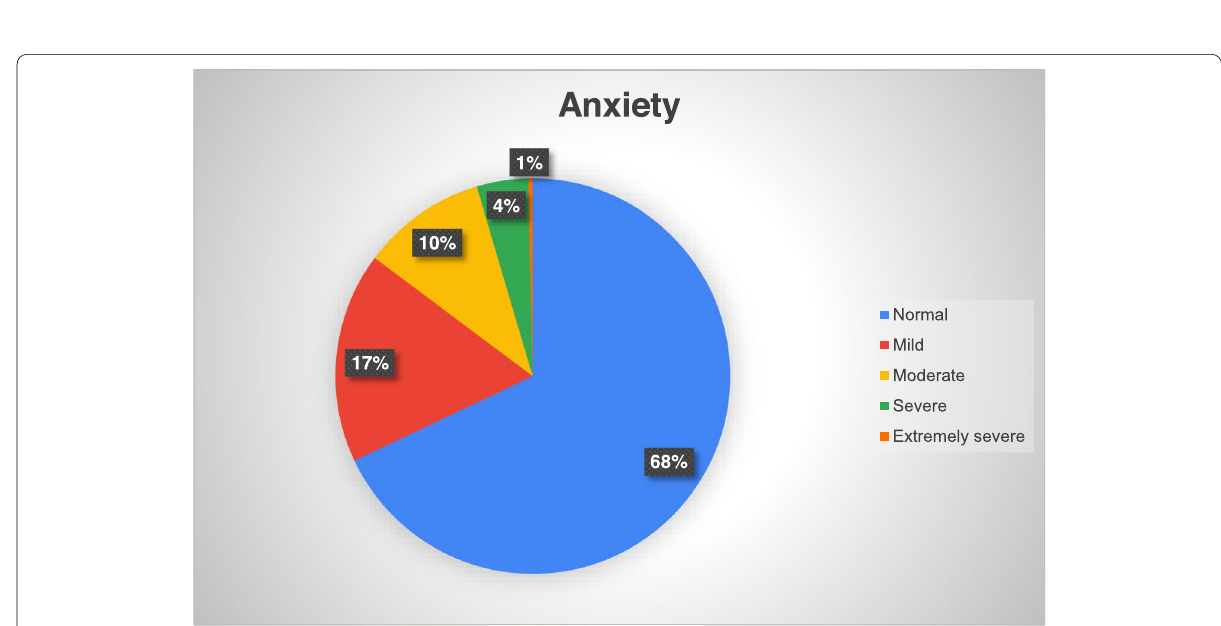
Fig. 2 Prevalence and severity of anxiety among the healthcare professionals using DASS-21 ( N